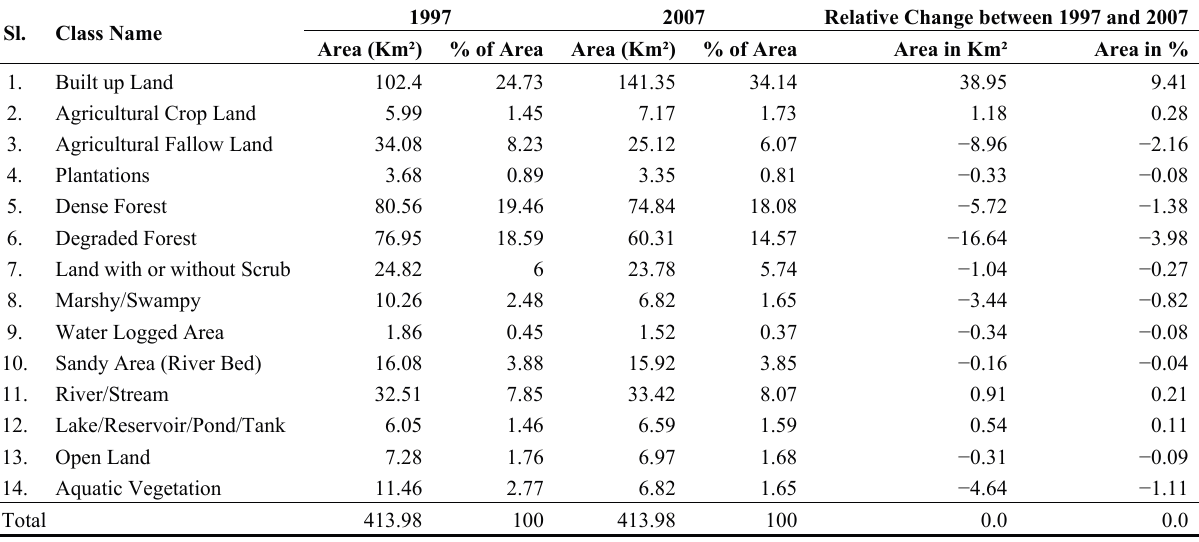
Table 6. Area statistics and relative changes of each land use and land cover changes category between 1997 and